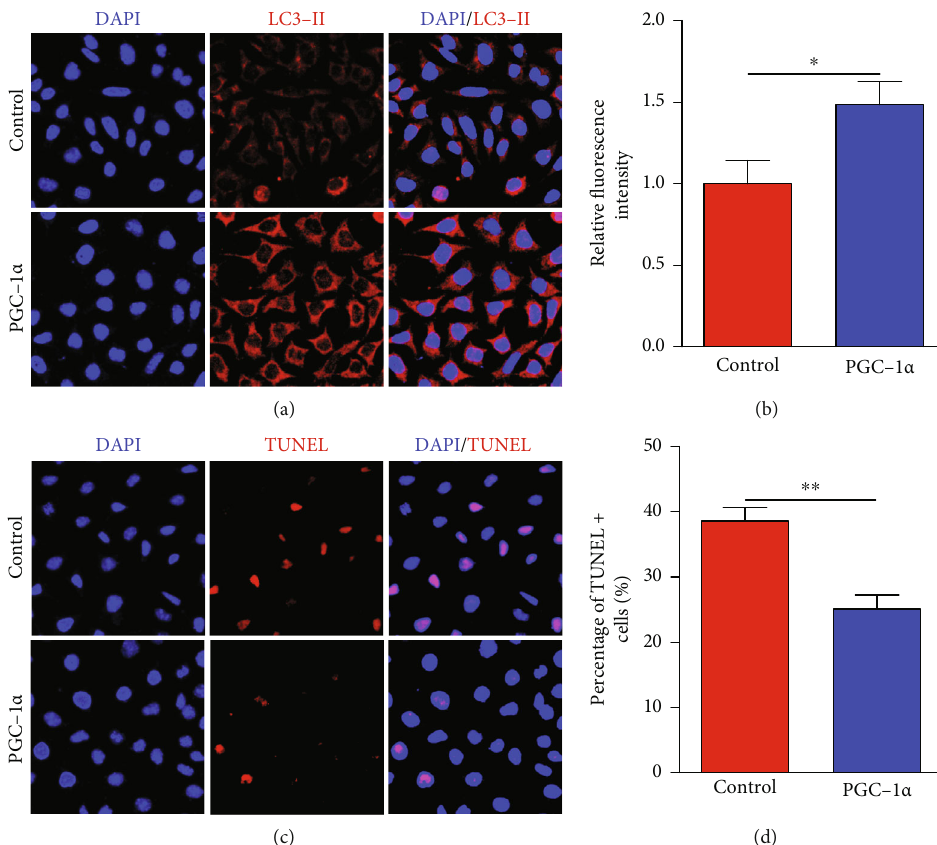
Figure 5: PGC-1 α promotes autophagy and reduces hippocampal neuron apoptosis. (a) Representative images of LC3-II level in HT-22 cells with or without PGC-1 α overexpression after OGD treatment. (b) Quanti fi cation of the relative fl uorescence intensity of LC3-II using ImageJ software. (c) Analysis of hippocampal neuron apoptosis using TUNEL staining after OGD treatment. (d) Quanti fi cation of the percentage of TUNEL + cells. ∗ p < 0 : 05, ∗∗ p < 0 : 01 ; n = 8 per